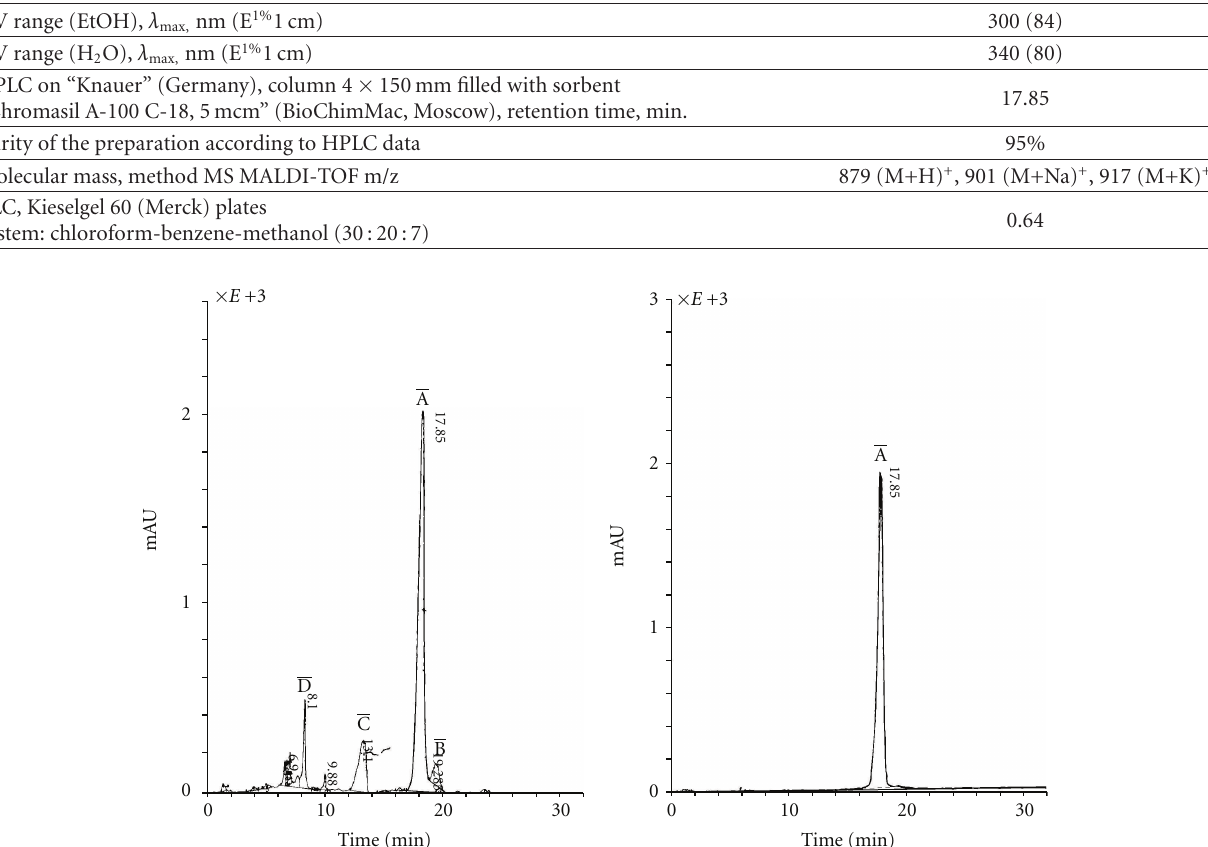
Table 2: Physical-chemical characteristics of antibiotic 70-A.